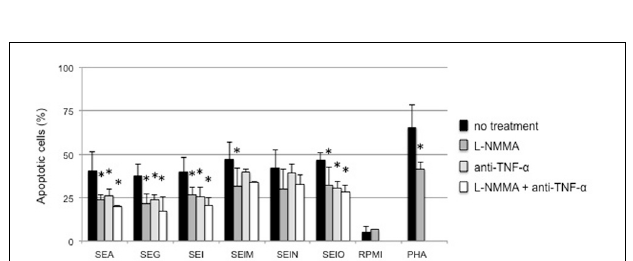
FIGURE 4 | Nitrite generation from SEs-stimulated PBMCs. NO was quantified with Griess reagent in the supernatant of PBMCs (10 6 cells/mL) incubated for 24h in a presence of EMEM, SEA, SEG, SEI, SElM, SElN, or SElO, with or without NOS inhibitor, L-NMMA (300 μ M). The results are mean ± SD ( n = 3 independent experiments). Asterisks indicate statistical significance compared to values obtained without the NOS inhibitor.